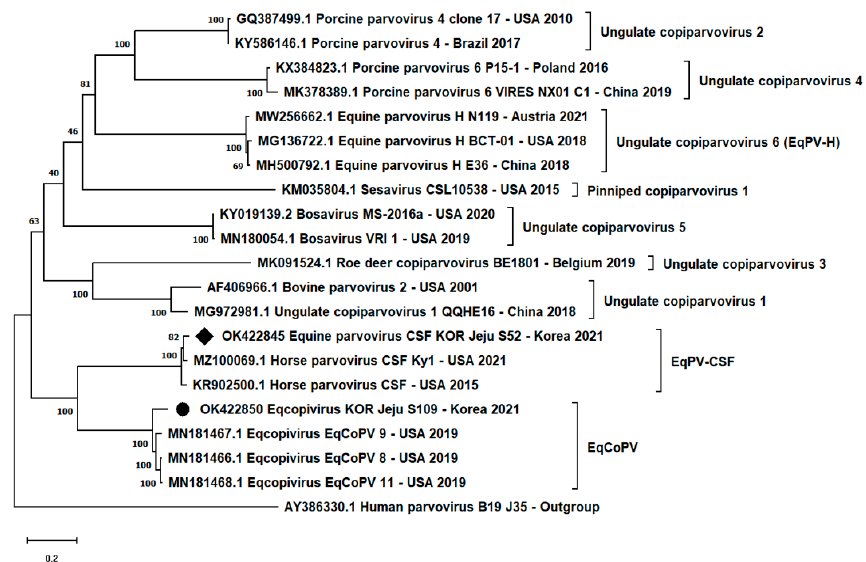
Figure 1. Phylogenetic analysis based on complete nucleotide sequences of genus Copiparvovirus . Korean isolates (EqPV-CSF: black diamond; EqCoPV: black circle) were analyzed with other members of the genus Copiparvovirus . GenBank accession number, country, and year of registration are labeled. Human parvovirus B19 (AY386330.1) was used as an outgroup. For analysis of the nucleotide and amino acid sequence identity, we compared the NS gene of each isolated virus with the representative virus in the genus Copiparvovirus . The